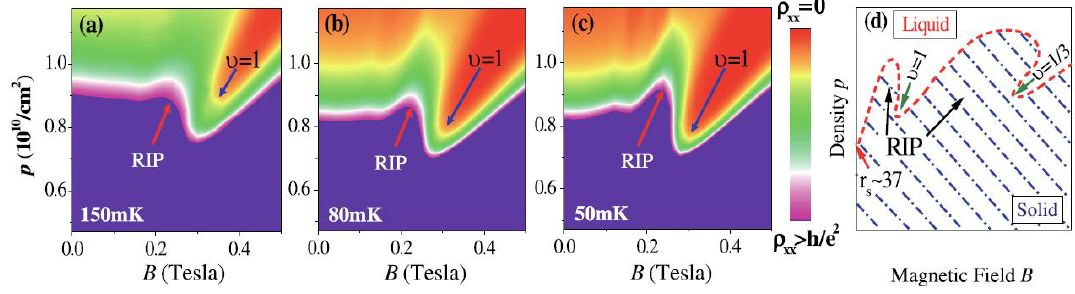
Figure 1. Longitudinal resistivity map plotted for the density ( p )—magnetic field ( B ) plane at T = 150 ( a ), 80 ( b ) and 50 ( c ) mK for dilute 2D holes in a 10 nm wide high mobility GaAs quantum well. The reentrant insulating phases (RIP) phase ( ρ xx > h / e 2 ) becomes more prominent at a lower temperature. ( d ) The proposed phase diagram includes the metal-insulator transition (MIT), RIP, integer and fractional quantum Hall (QH) states. Figure was adapted from Reference [10].